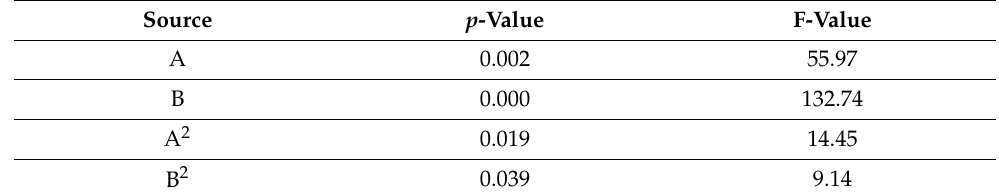
Table 3. Analysis of variance after removing non-significant factors.